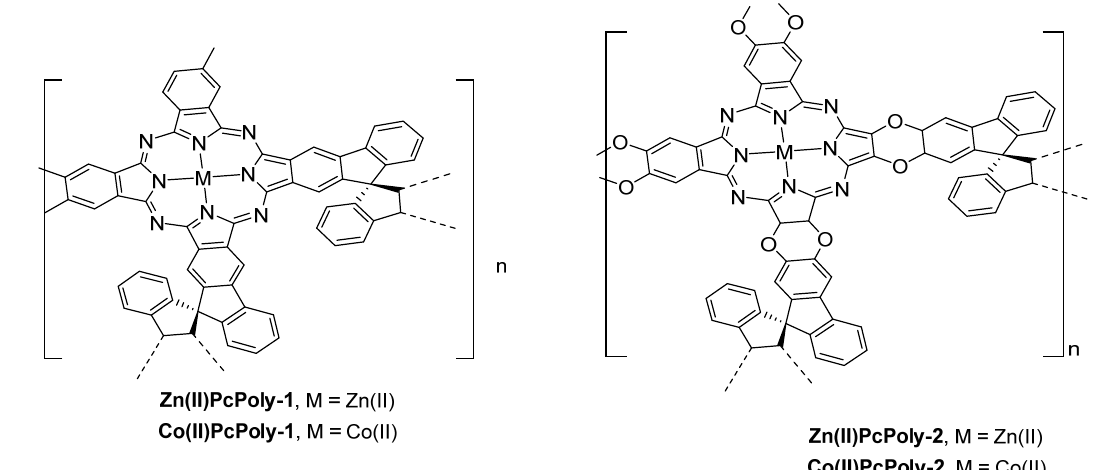
Figure 14. Structures of Zn(II) and Co(II) phthalocyanines network polymers, prepared by Kimura and coworkers (adapted form [63]).